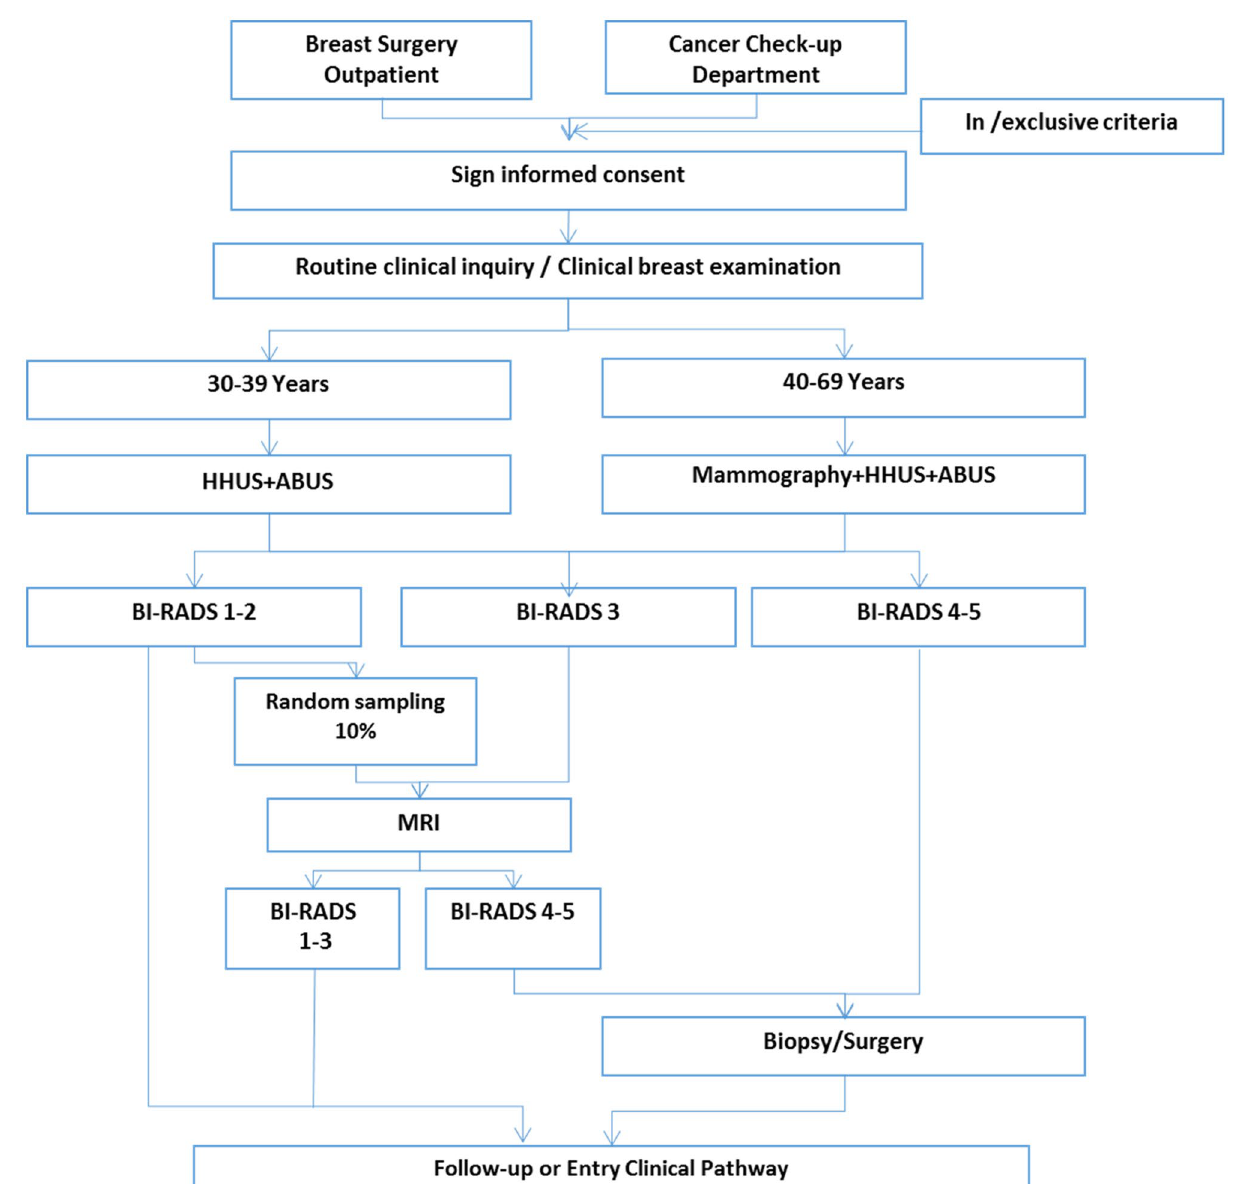
Figure 1. Flowchart showing patient selection and study